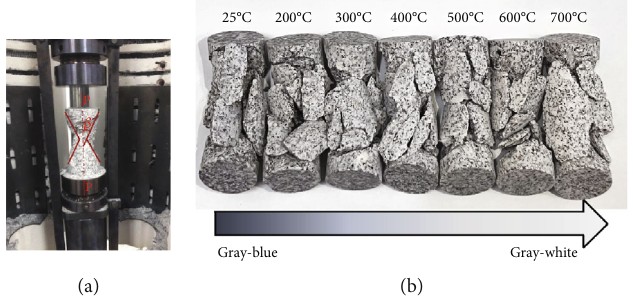
Figure 2: Macroscopic failure morphology of granite samples. (a) Failure morphology of the granite sample in the uniaxial compression test. (b) Color change and failure morphology of granite samples under di ff erent real-time high